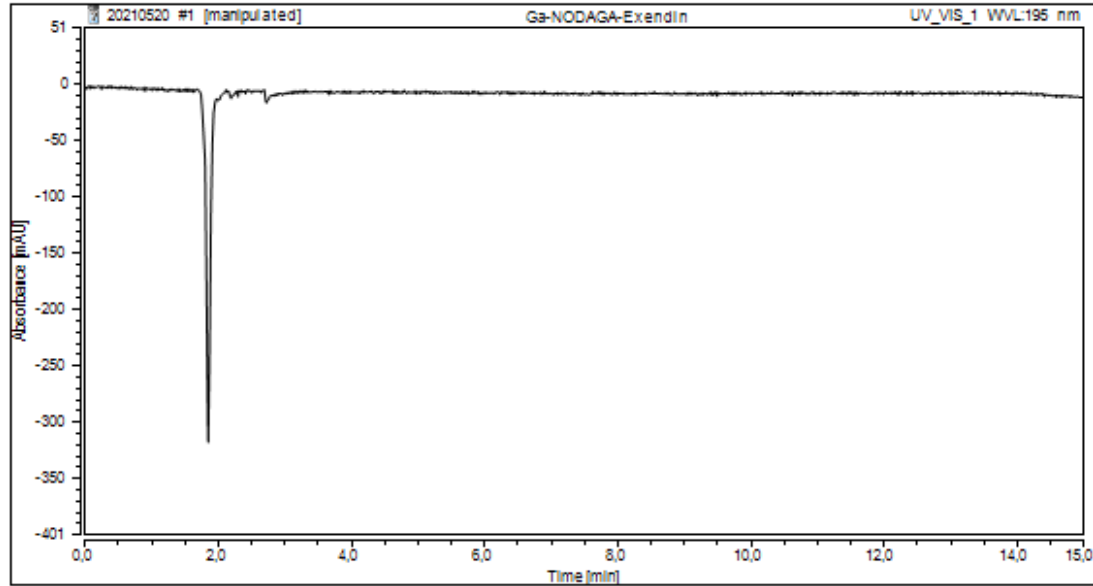
Table 3. Residual content concentration of HEPES in [ 68 Ga]Ga-Radiopharmaceuticals. Radiopharmaceuticals